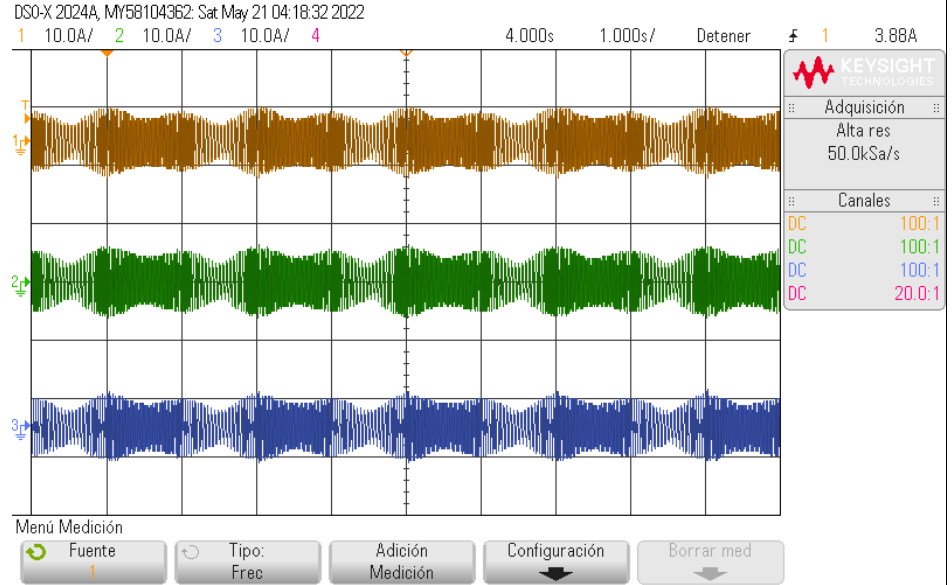
Figure 15. 10 s of oscilloscope currents wave-forms with harmonic insertion for mechanical parame- ters estimation lasting 30 s